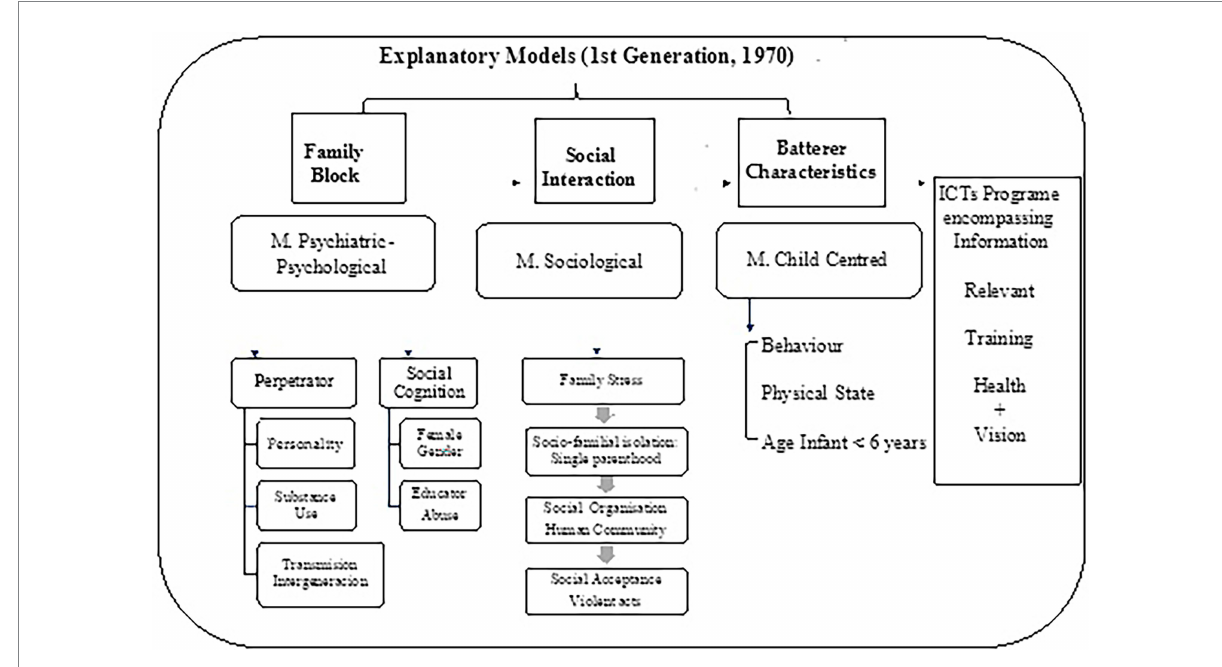
FIGURE 3 First-generation explanatory models. Health education and learning in health sciences converge with the development of new information technologies: a relevant link between training and health care (Author’s own